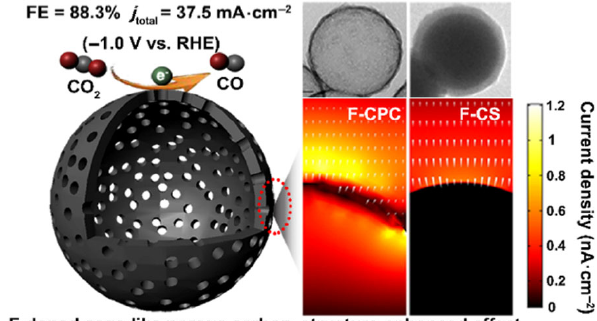
cage-like carbon catalyst. Reproduced with permission from Ref. [34], © American Chemical Society